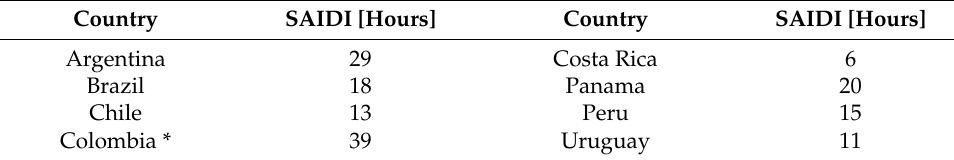
Table 1. Average annual duration of interruptions for Latin American countries [11]. Country SAIDI [Hours] Country SAIDI [Hours] Argentina 29 Costa Rica 6 Brazil 18 Panama 20 Chile 13 Peru 15 Colombia * 39 Uruguay